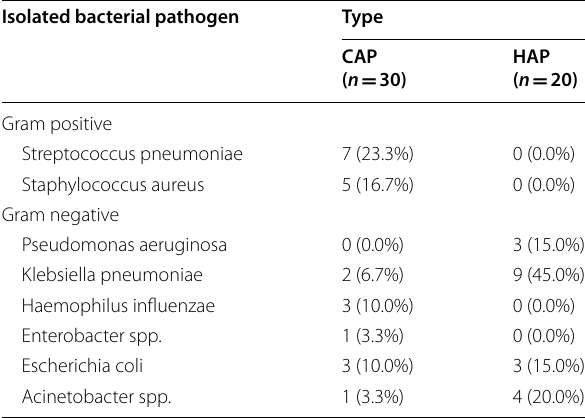
Table 3 Frequency of isolated bacterial pathogen